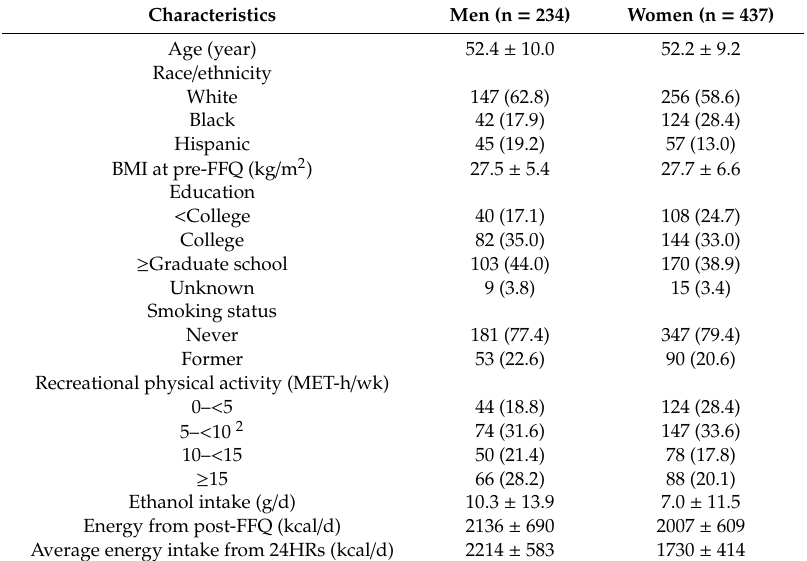
Table 1. Characteristics of participants in the Cancer Prevention Study-3 Diet Assessment Sub-study 1